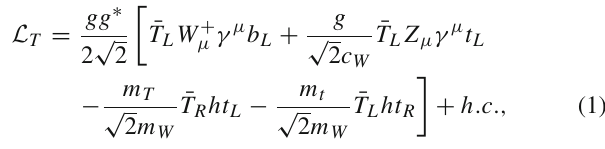
quarks. The results based on this simplified effective theory can be used to make predictions for more complex models including various types of top partners. The general effective Lagrangian of the top partner sector can be described by